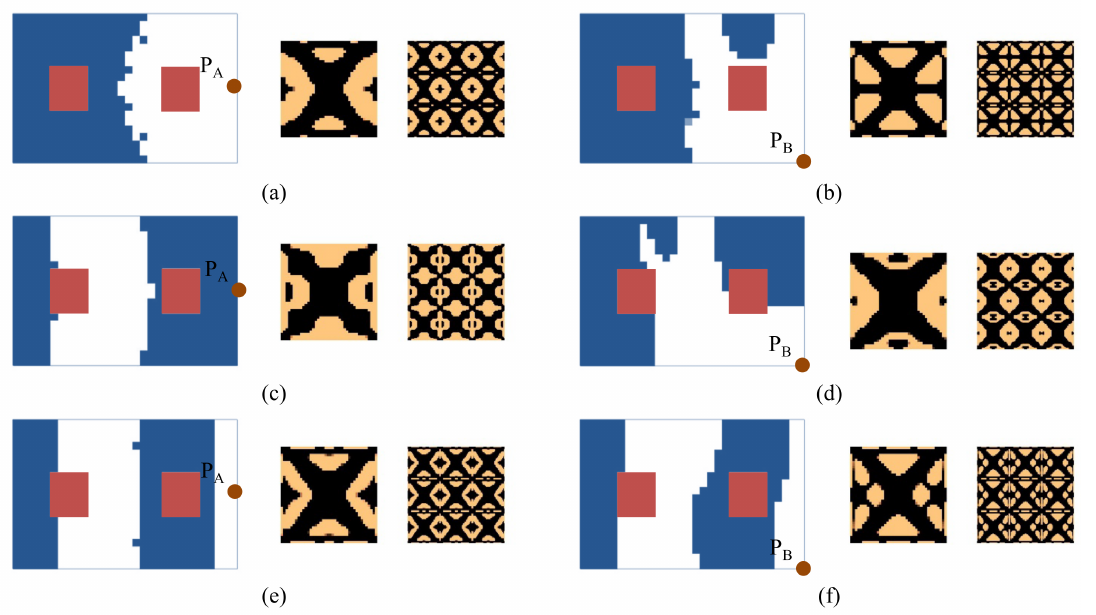
Figure 25. Design results of the cantilever composite plate shown in Figure 5. ( a ) Excitation frequency